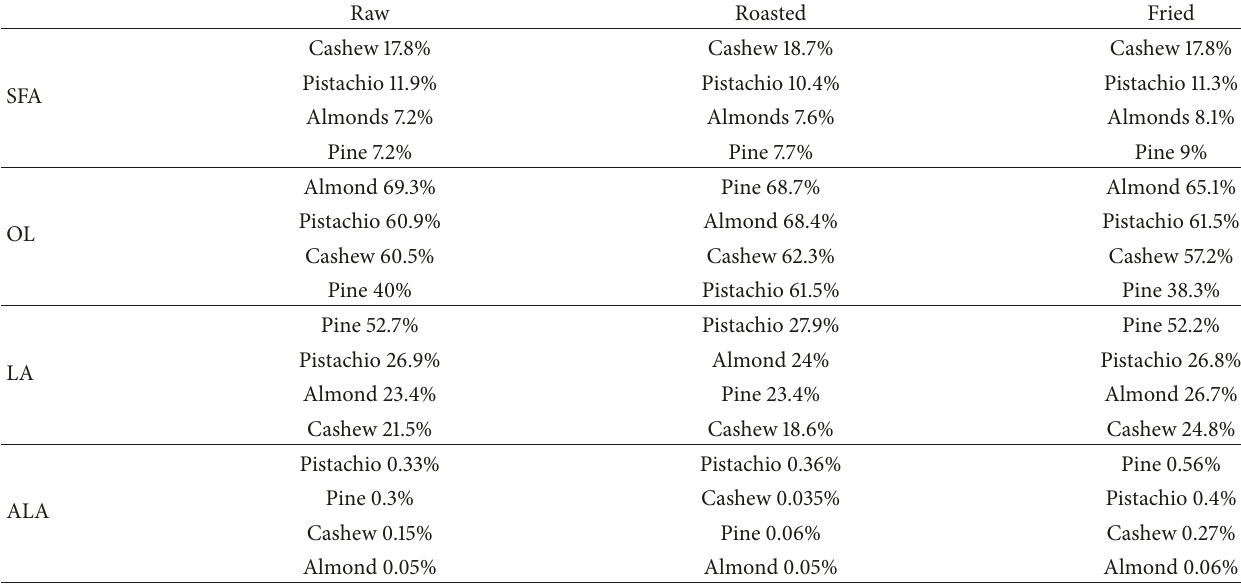
Table 3: Appraisal between the percentage of fatty acids content among raw and heat-treated nuts.